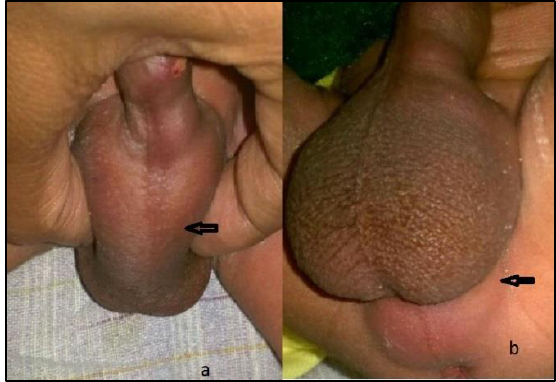
Figure 1: Periurethral abscesses around penile urethra in scrotal area (a) and perineum